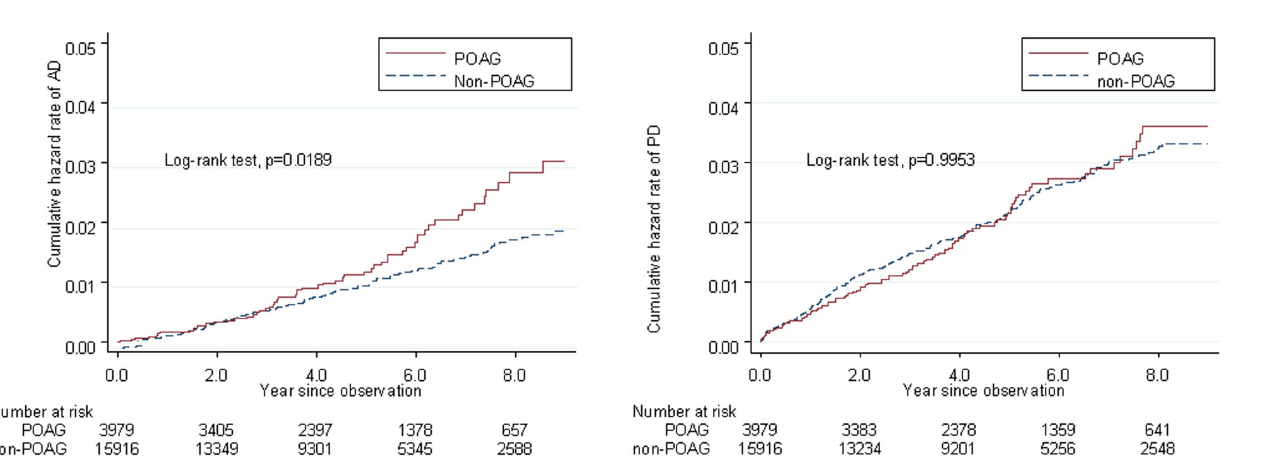
Figure 2. Kaplan-Meier failure curve of patients with POAG and non-POAG who developed PD after accounting for censoring due to death or end of observational